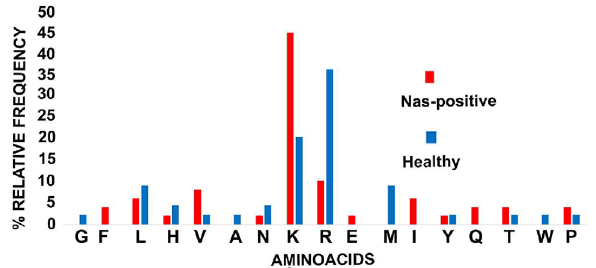
Figure 3. Relative amino acid frequencies at the C-terminus. The figure illustrates the relative distribution of C-terminal amino acids in unique and significantly differential peptides found in NAS-positive (red) and healthy milk (blue),